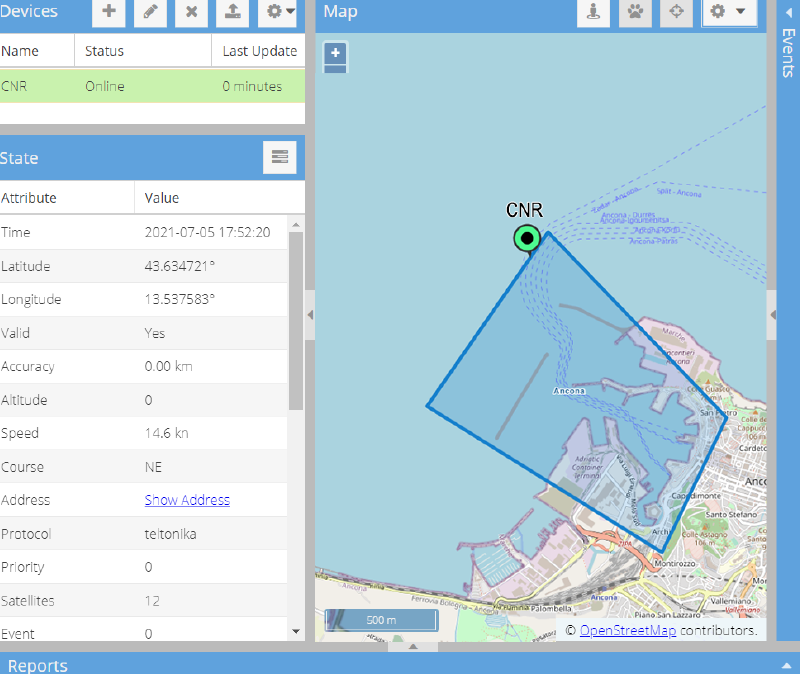
Figure 3. The Web interface of the Sencha ExtJS framework, the equipped small vessel (green point), and the geofence of its homeport (Ancona, Italy). The geofence was defined in Traccar and used in post processing to validate the estimated